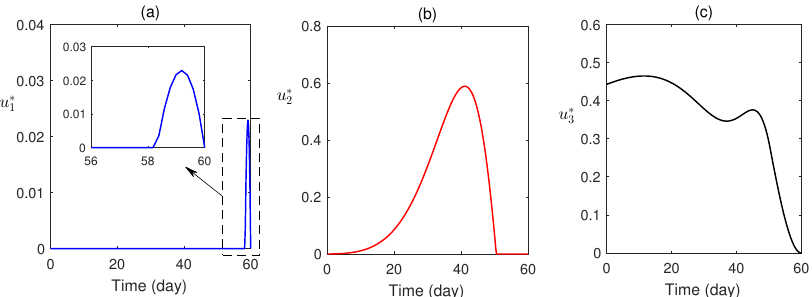
Figure 9. The profiles of optimal controls are plotted as a function of